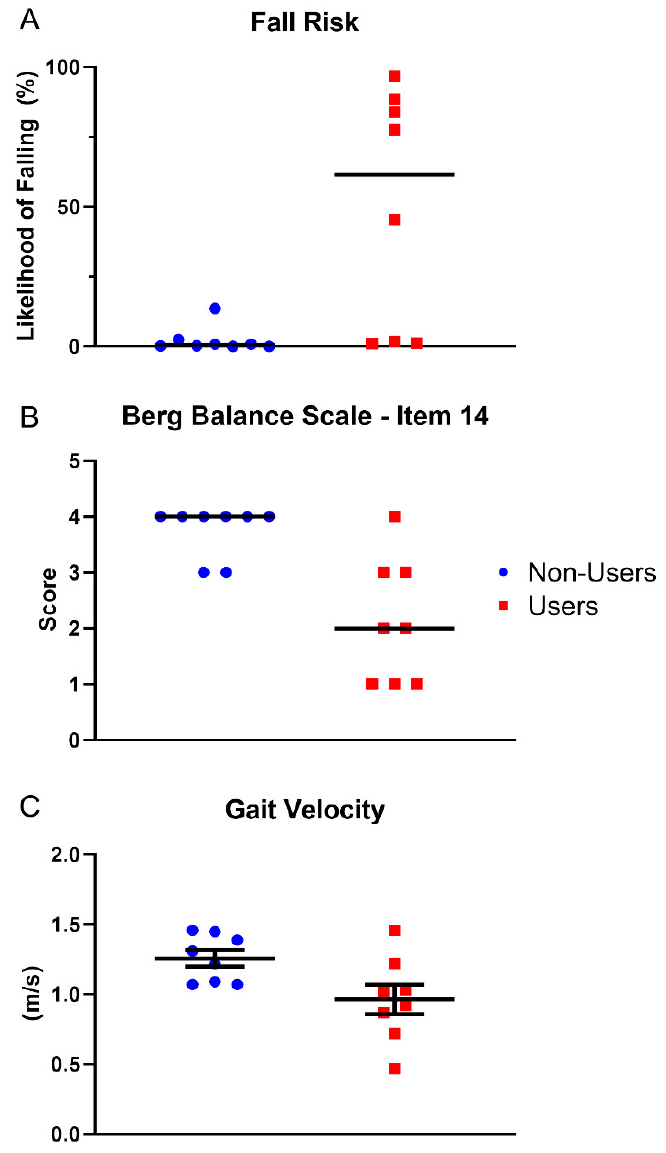
Figure 1. Plots of significant differences between cannabis Users vs. Non-Users in ( A ) fall risk, ( B ) Berg Balance Scale—Item 14, and ( C ) gait velocity. Individual subject scores within each group are represented by the different data points (n = 8 per group). The horizontal bars in A and B indicate the median and the bars in C represent mean ± SEM. Table 2. Central tendency, variability, significance, and effect size ( d or A ) for all variables compared between cannabis Users and Non-Users. Data are mean ± SD or median (range). Significant p -values are in bold.